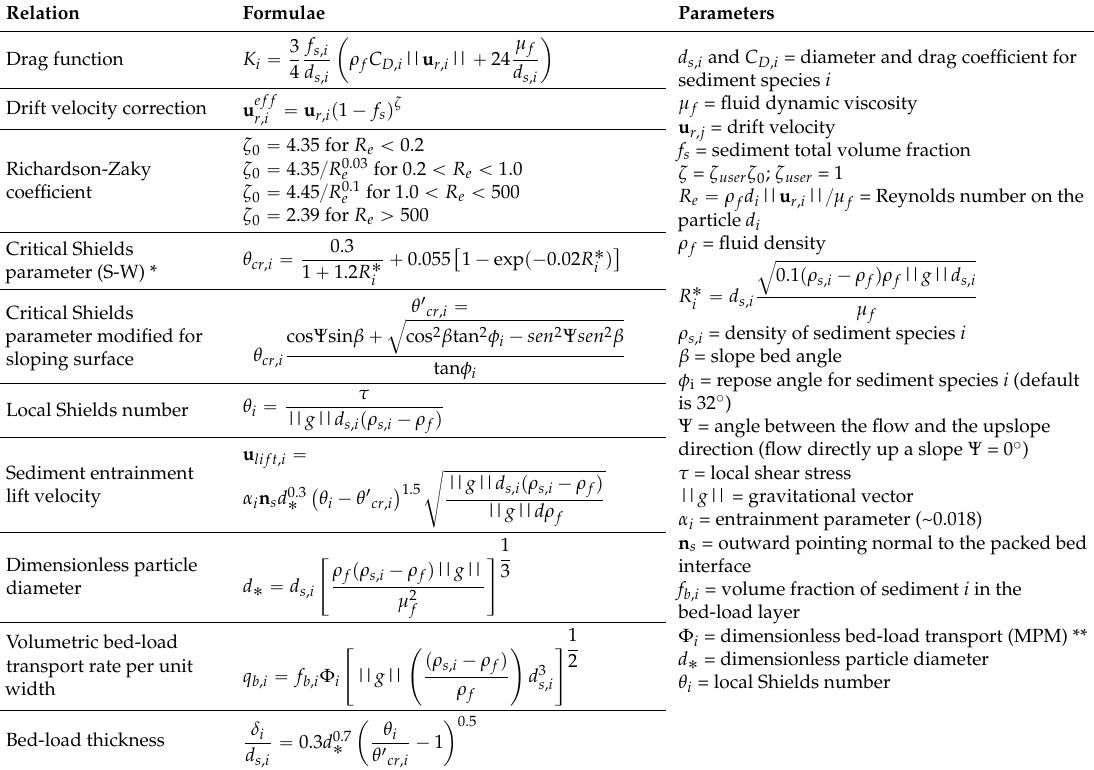
Table 8. Principal relations to calculate the sediment scour model in